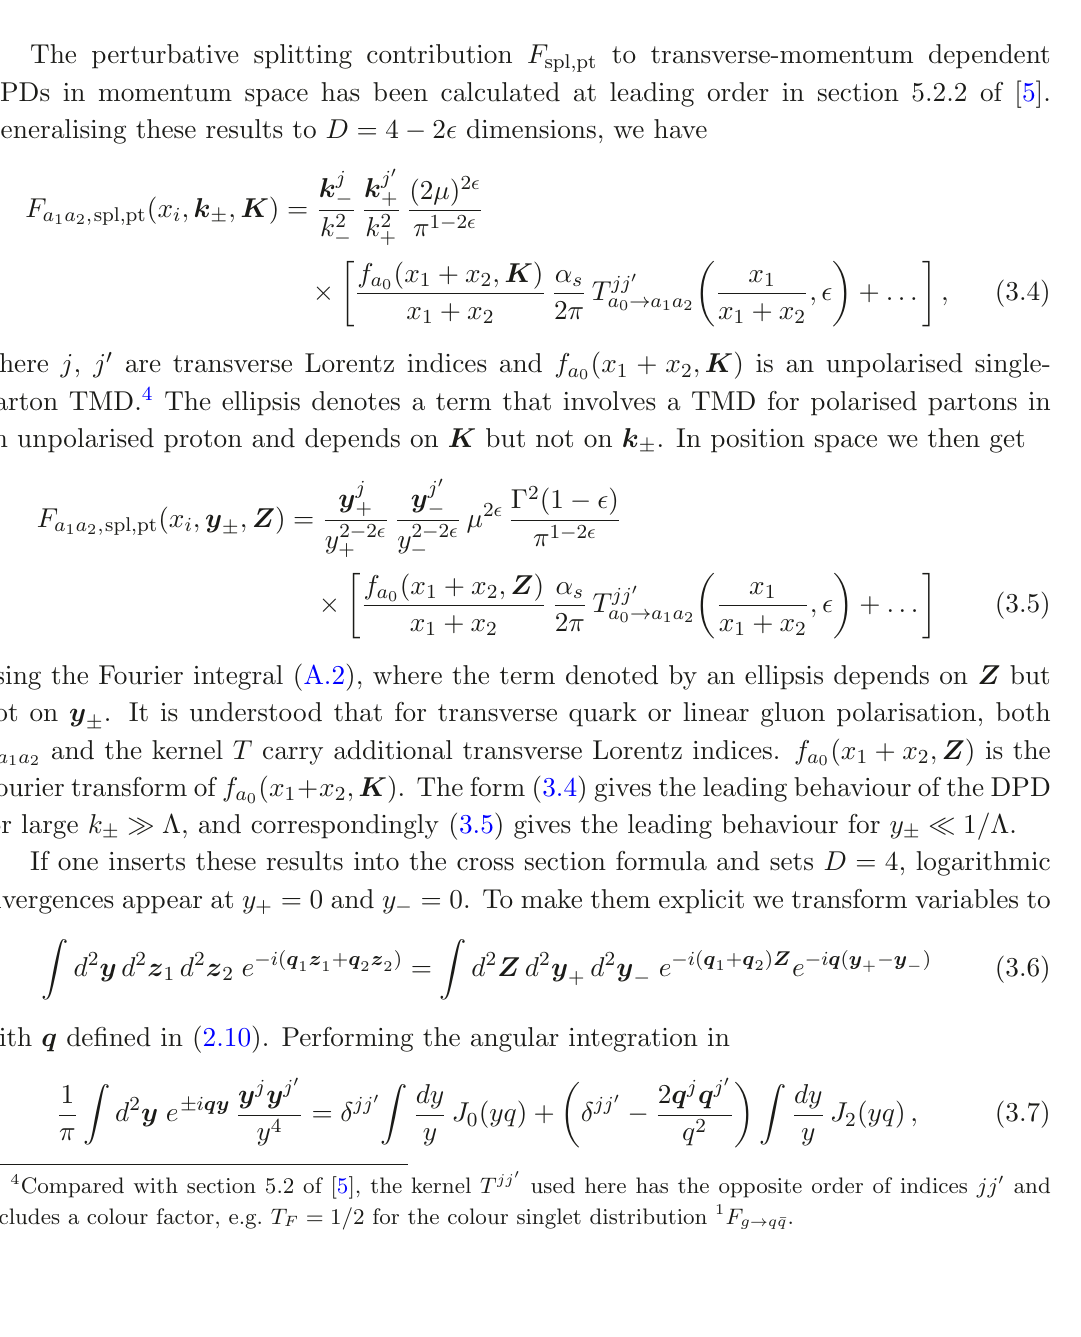
Figure 4 . The perturbative splitting mechanism for a DPD, with momentum and position assign- ments. Here and in the following, the line for the final-state cut of the spectator partons is not shown for